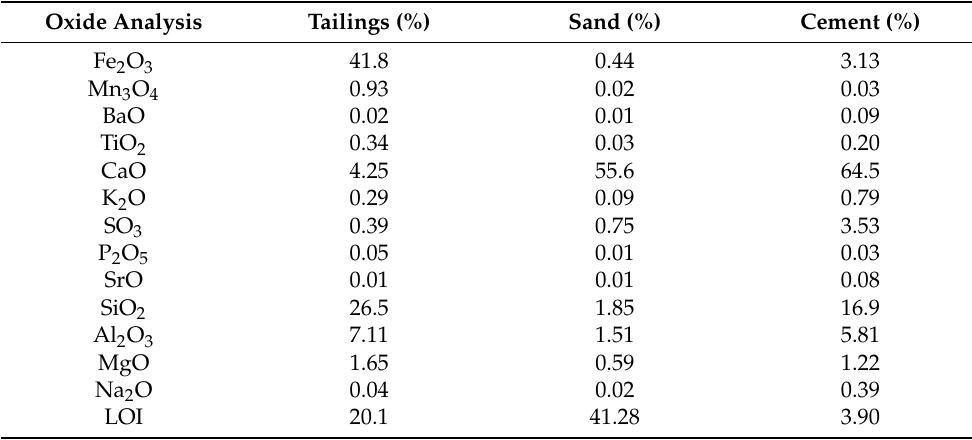
Table 2. Oxide analyses of tailings/sand/cement